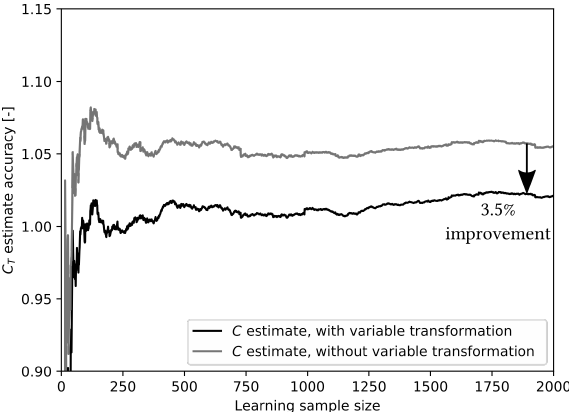
Figure 4. Evolution of the accuracy of the estimate of Taylor’s parameter C T with learning sample size.